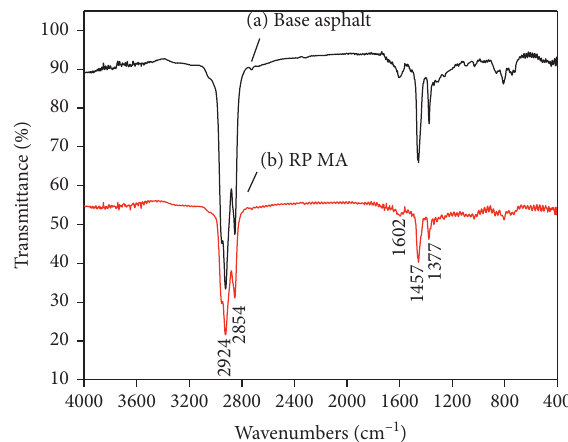
Figure 14: FTIR spectra of the base asphalt and rubber powder- modified